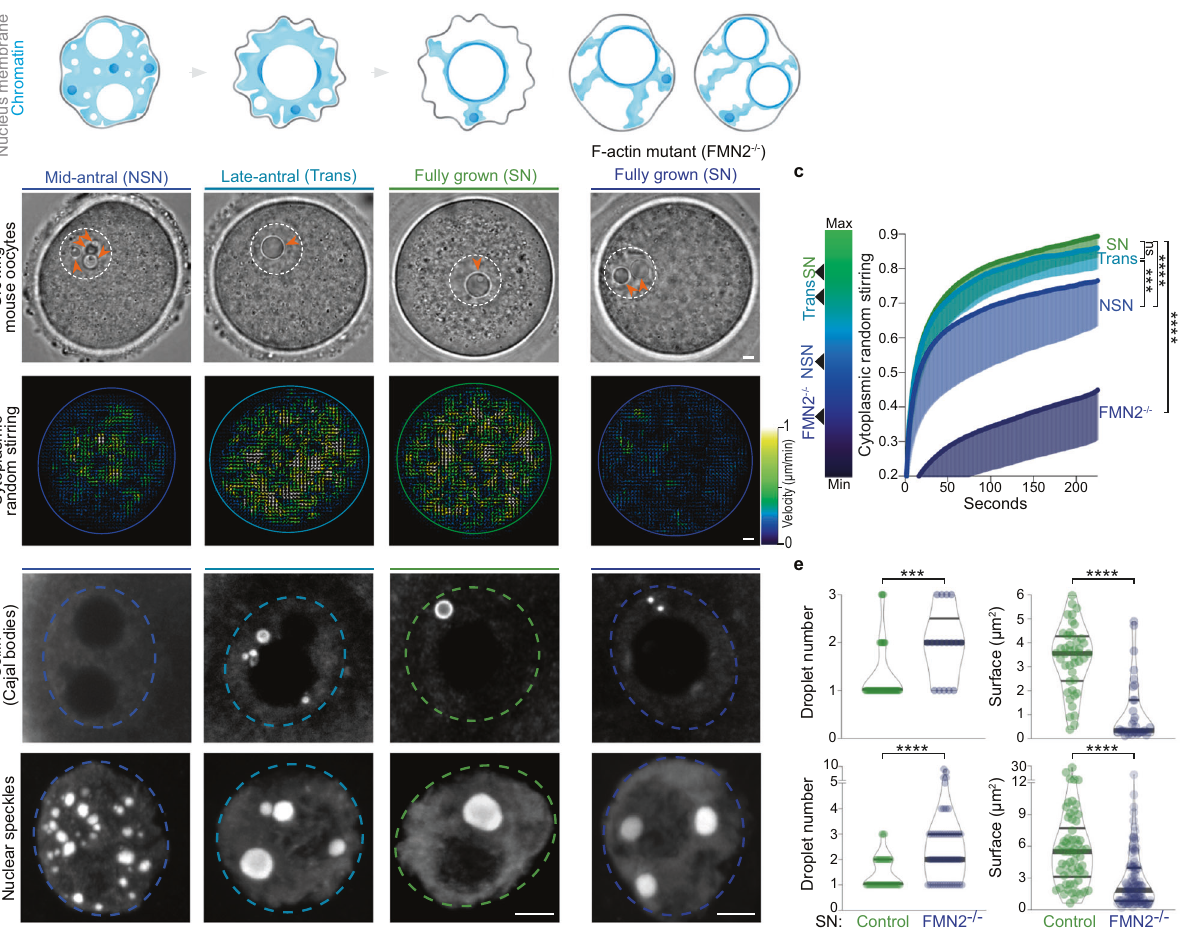
Fig.1|Nuclearbiomolecularcondensatepatternsduringmouseoocytegrowth correlatewithcytoplasmicremodeling.a Illustrationofchromatincon fi guration evolution (non-surrounded nucleolus (NSN), transitioning (Trans), surrounded nucleolus (SN)) coinciding with oocyte growth subcategories (mid-antral follicle, late-antral follicle, and fully grown); (left) large spherical nucleoli decrease in number and increase in size as of the Trans-stage; (right) chromatin con fi guration scenarios in fully grown cytoplasmic F-actin mutants (FMN2 − / − ) with one large or two smaller nucleoli. The nuclear membrane (gray) is depicted according to fl uc- tuation intensity. b Top: Bright- fi eld images of Control oocytes with growth pro- gression and a fully grown mutant; the nucleus is in dashed white and orange arrowheads indicate multiple smallnucleoli(NSN and FMN2 − / − SN) or a single large nucleolus (Trans and SN). Bottom: Growth-associated cytoplasmic stirring vector maps generated by STICS analyses of bright- fi eld 240s-stream videos; the oocyte cortex is outlined with colors re fl ecting the intensity of cytoplasmic stirring; maps are color-coded according to velocity magnitude (lowest in dark blue, strongest in